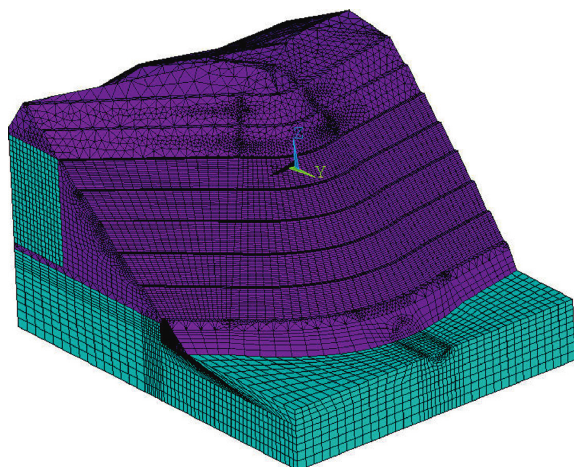
Figure 6: Numerical calculation model.